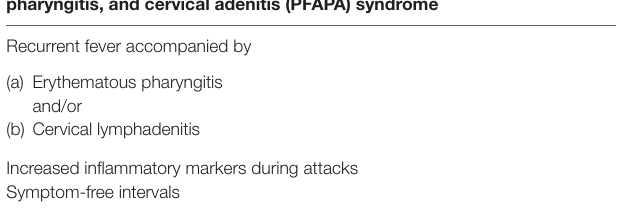
TaBle 4 | Clinical diagnostic criteria resulting from the multivariate analysis. TaBle 3 | Estimations derived from multivariate logistic regression analysis